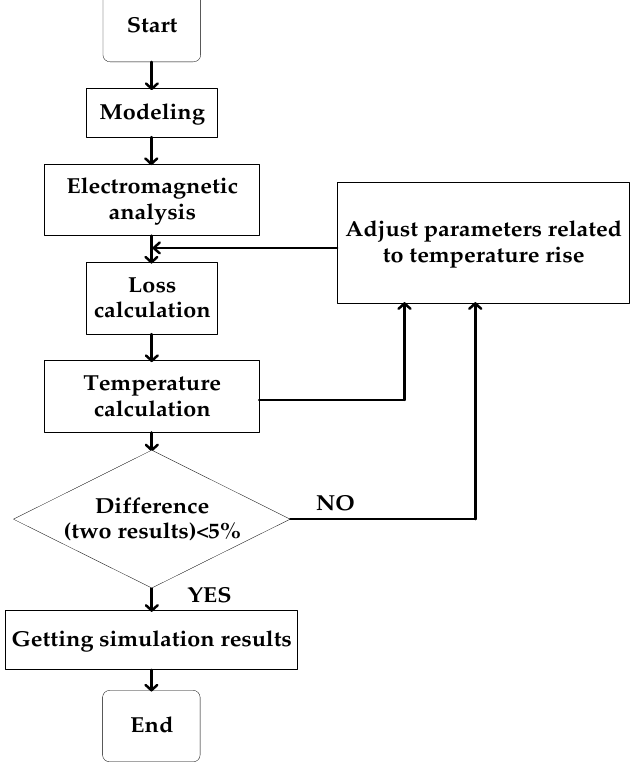
Figure 6. Magnetic thermal coupling analysis flow chart.